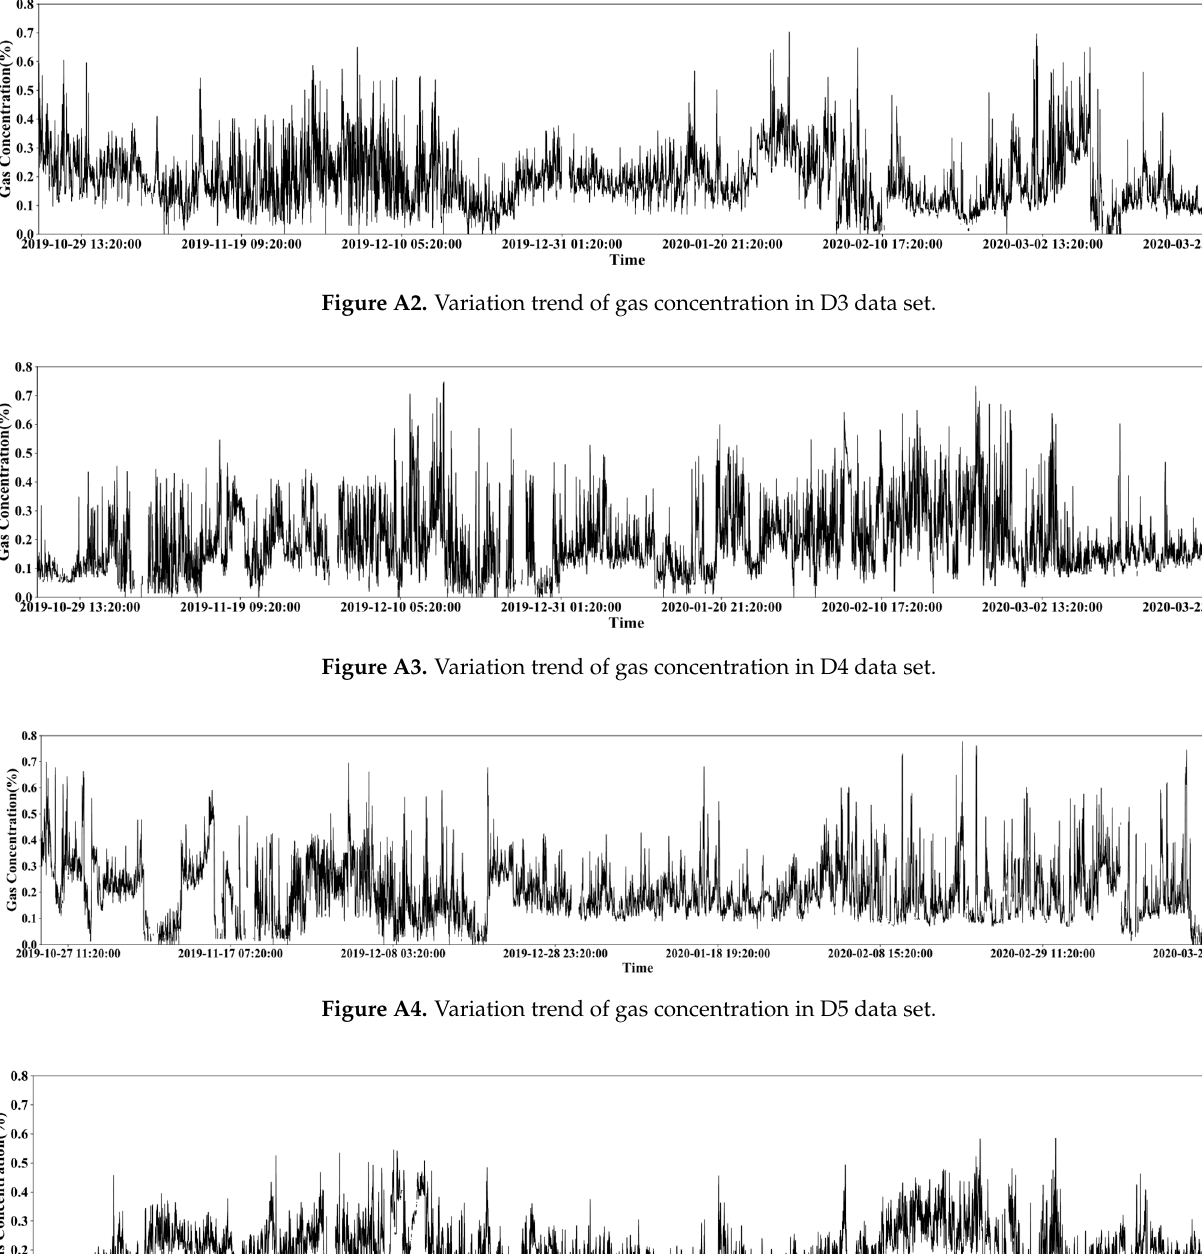
Figure A1. Variation trend of gas concentration in D2 data set.